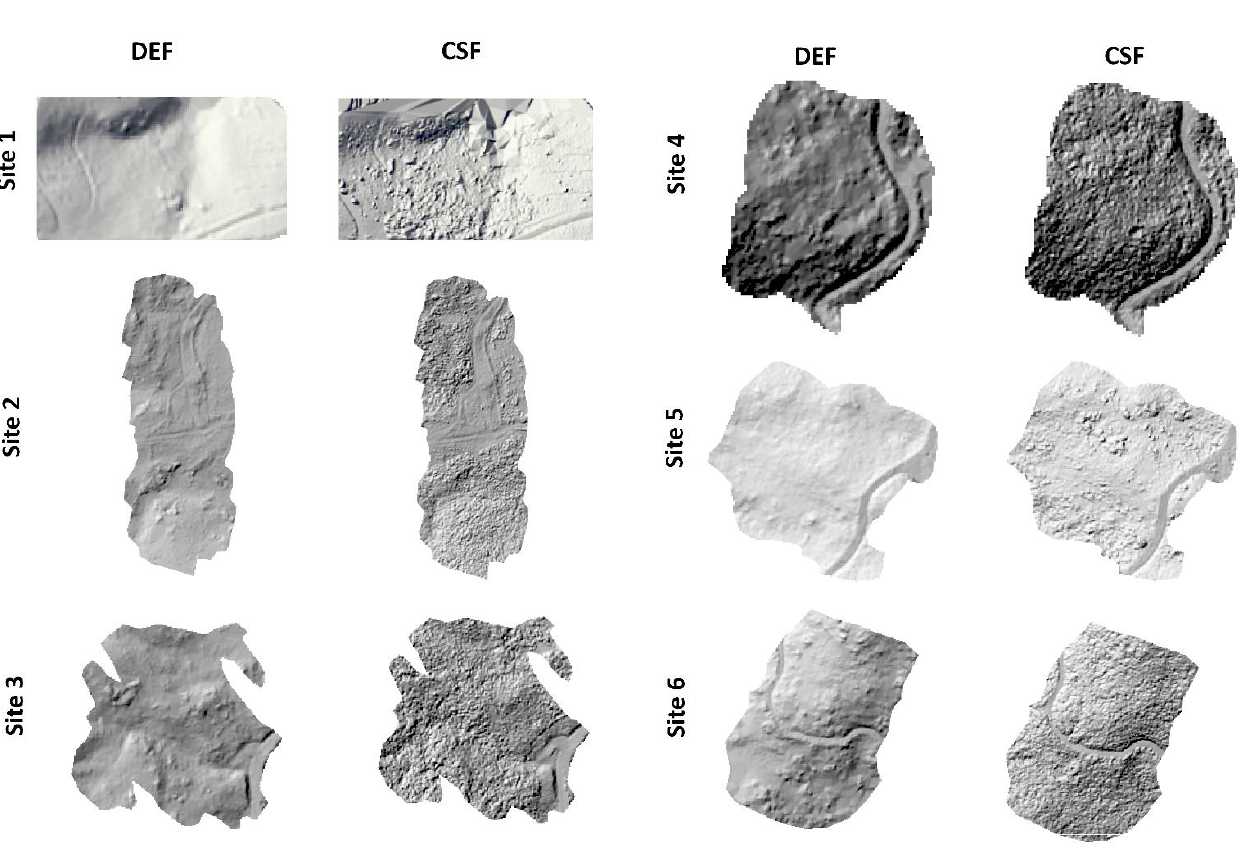
Figure 3. Hillshades from DEMs (at 1 m pixel size for better interpretation) derived from high-density LiDAR data using TIN densification with default parameters (DEF) and the segmentation-based filtering, the “Cloth Simulation Filter” (CSF).